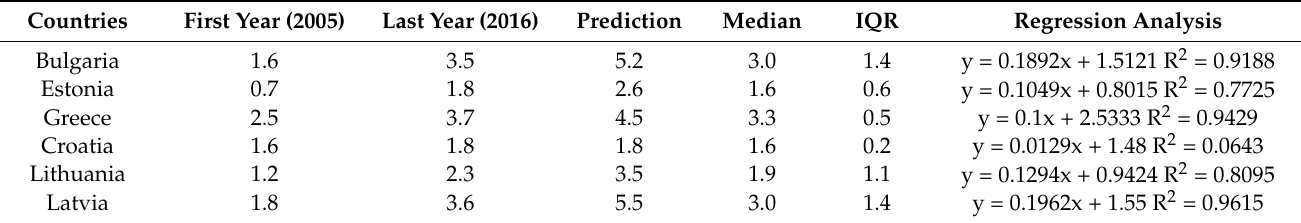
Table 5. Indicator values of total number of scanners for computed tomography per 100,000 inhabitants—value of first observed year, last observed year, predictive value, median value, inter-incremental difference and linear regression analysis.